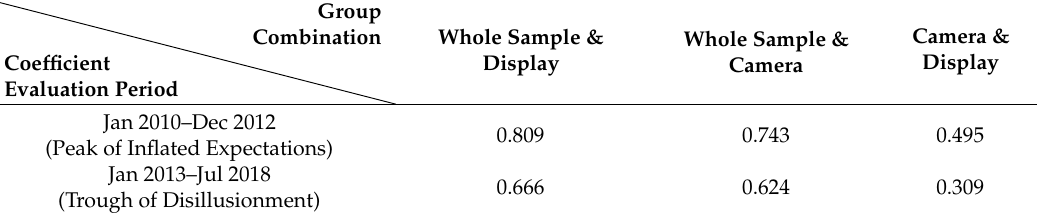
Figure 22. Monthly rate of return for Jan 2013–Jul 2018. Table 7. Cross-correlation coefficient between monthly rate of return (lag = 0).